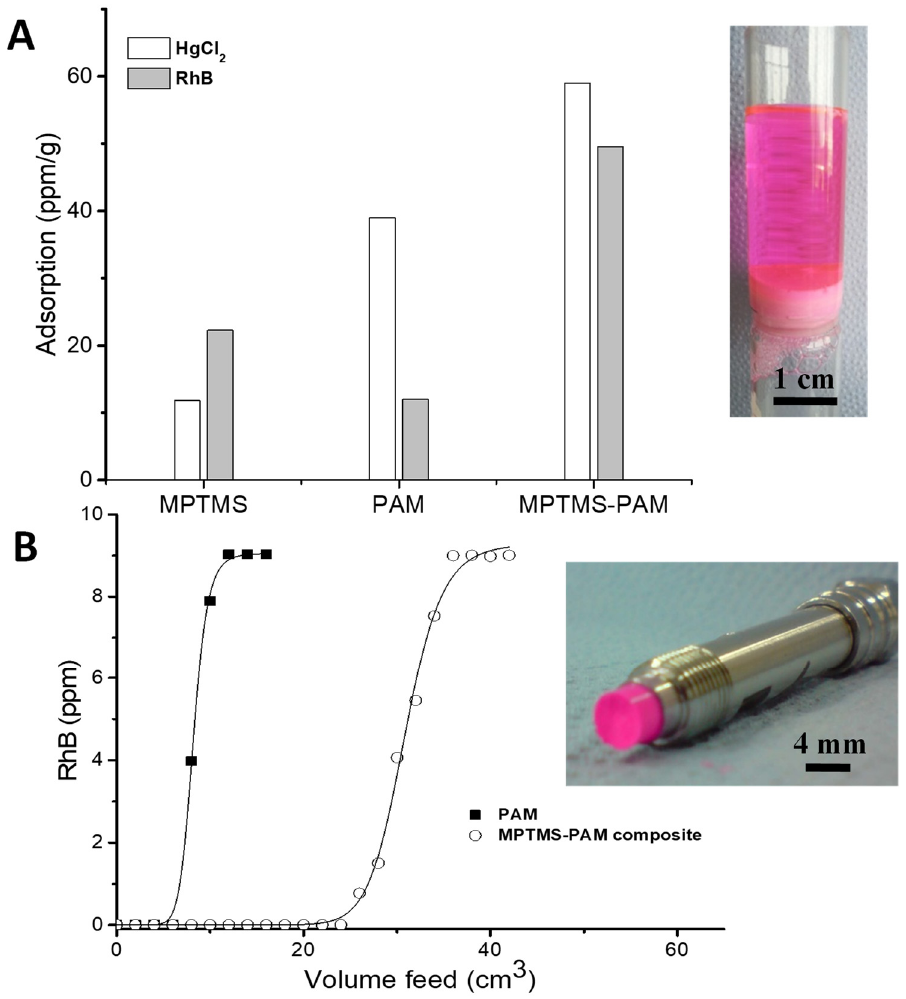
Figure 10. ( A ) Adsorption performance of MPTMS silica microspheres, PAM monolith and MPTMS silica–PAM composite monoliths for the removal of Hg ions (as in HgCl 2 ) and rhodamine B (both concentrations at 200 ppm). The solution (20 cm 3 ) was pushed through the monolith filter (as shown in the inset) by gravity. ( B ) A breakthrough flow test of RhB solution (10 ppm) with the PAM and MPTMS silica–PAM monoliths encased in the stainless-steel column. A photo of the unpacked column after the test is shown as the inset